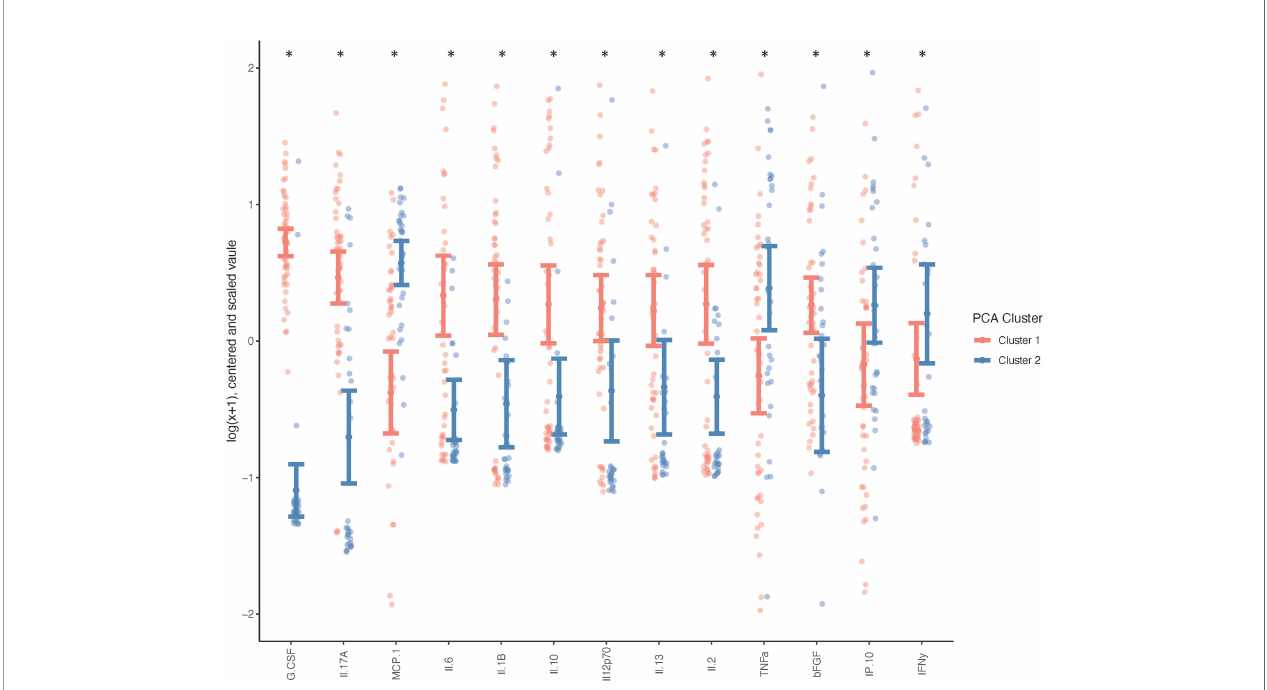
FIGURE 3 | Systemic Cytokine Differences between Patient Clusters. Wilcoxon test was performed on cytokines indicated as differently expressed between clusters (n=50 cluster 1, n=33 cluster 2), and adjusted for age, sex, BMI and total joint count (*p < 0.05, q < 0.1) and graph indicates the direction of differential expression between the two